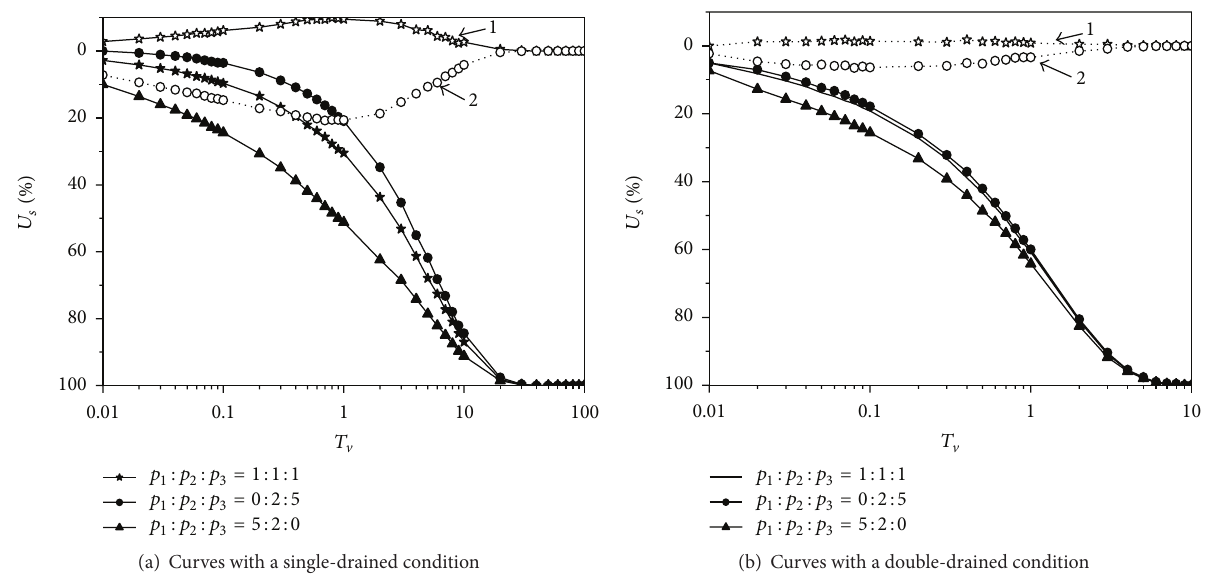
Figure 7: Consolidation curves with different drainage